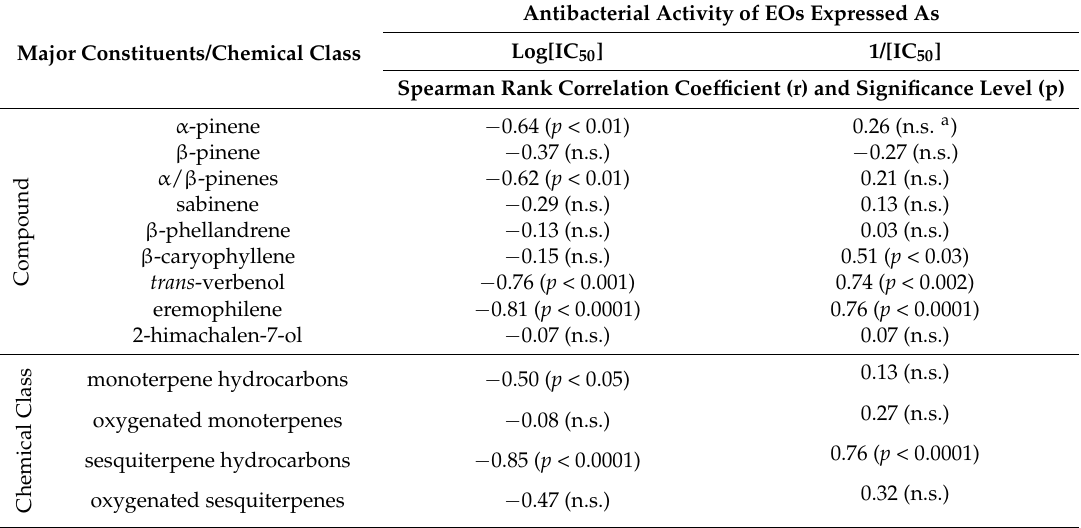
Table 3. Correlation coefficients of a linear regression analysis between antibacterial activity of the EOs and their compound composition based on GC-MS